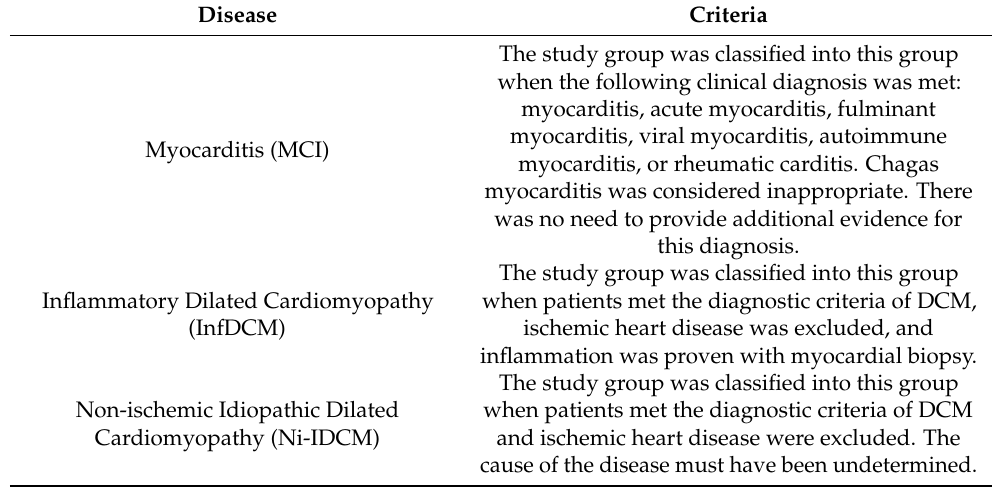
Table 3. Study groups classification criteria.